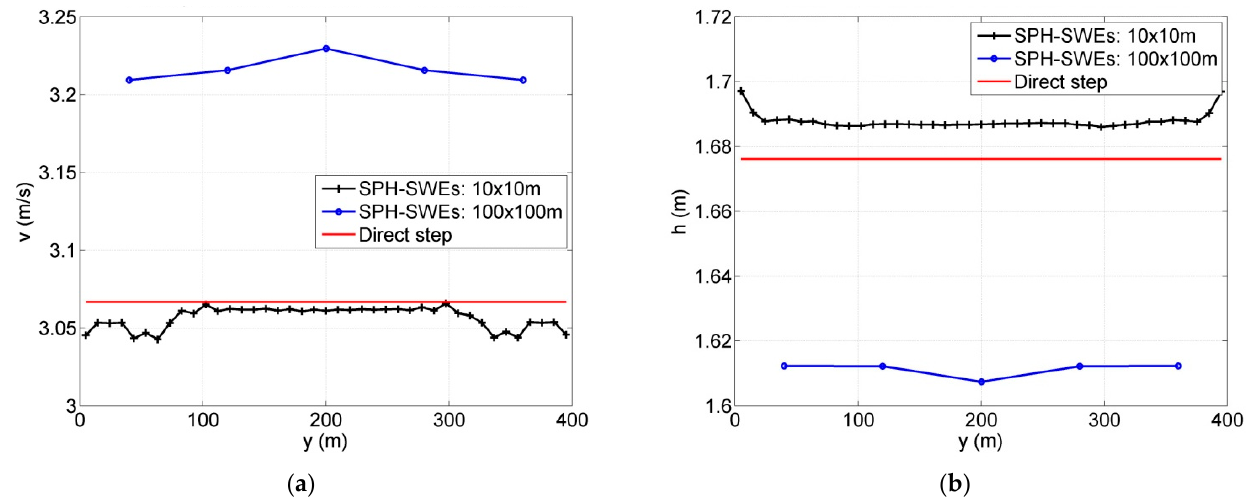
Figure 9. Results of 2D simulation for M2 curve cross-sectional view: ( a ) velocity and ( b ) water level. Table 5. Maximum reported error.